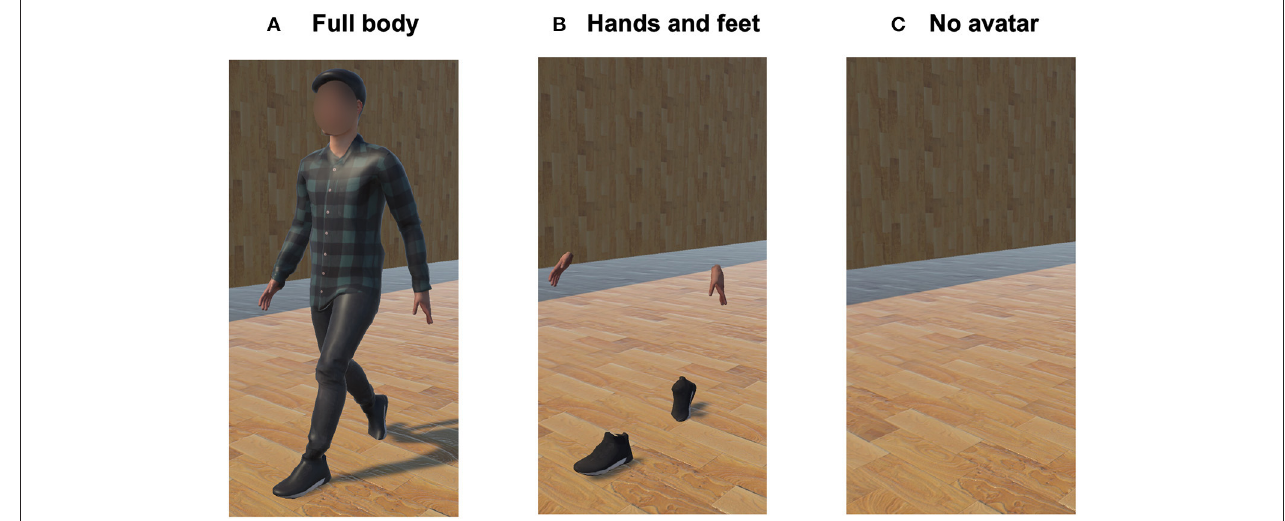
FIGURE 3 | Avatar conditions. (A) Full-body avatar; (B) hands-and-feet-only avatar; (C) no-avatar condition.